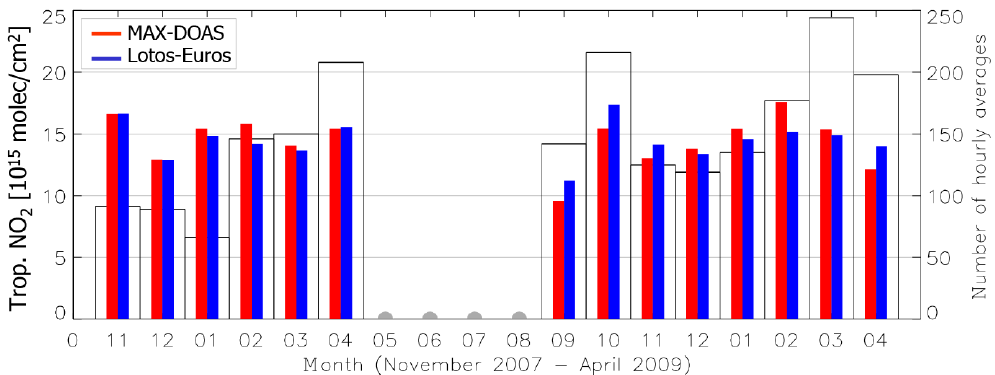
Figure 8. Average tropospheric NO 2 columns for each month in the data set. No measurements were performed from May to 10 September 2008. In black, the number of hourly averages for that month is shown, which is lower in the wintertime because of the shorter daylight period. Days with instrumental problems have also reduced the number of observations for some months.